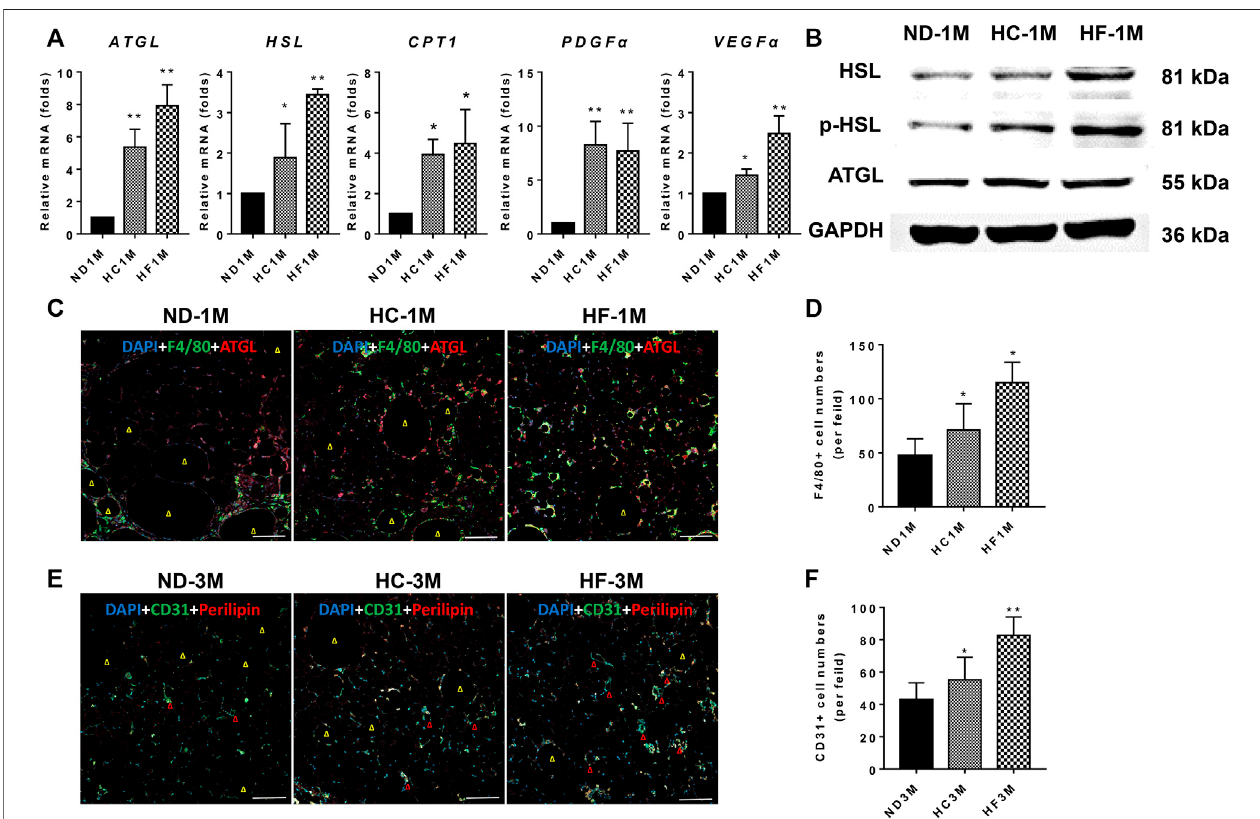
FIGURE 4 | Expression changes of genes related to lipolysis and angiogenesis. (A) The mRNA expression levels of ATGL, HSL, CPT1, PDGF α , and VEGF α . (B) Western blotting analysis of ATGL, HSL, and p-HSL. (C,D) Representative immuno fl uorescence staining of ATGL (red) and F4/80 (green) in 30-days grafts, and the number of macrophages (F4/80 + cells) quanti fi ed. (E,F) Representative immuno fl uorescence staining of Perilipin (red) and CD31 (green) in 90-days grafts, and the number of CD31 + cells quanti fi ed. Grafts on day 30 are marked as ND-1M, HC-1M, and HF-1M. Yellow arrow: oil cyst. Red arrow: microvessel. Scale bars = 100 μ m ** p < 0.01 and * p <